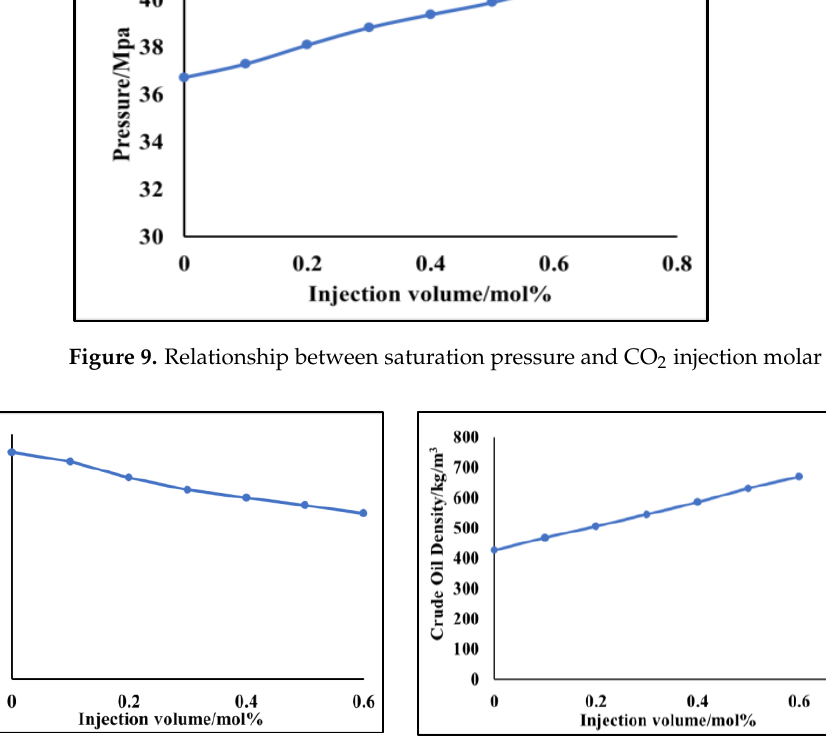
Figure 10. Variation of crude oil viscosity and crude oil density under different CO 2 injection molar quantity: ( a ) oil viscosity and ( b ) oil density.